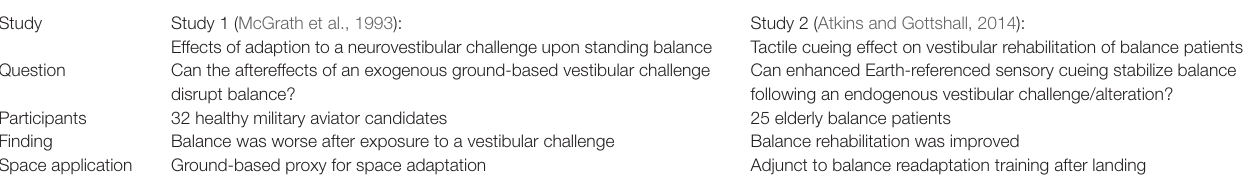
TABLE 2 | The two preliminary studies briefly reviewed in this article. Study 1 (McGrath et al., 1993):